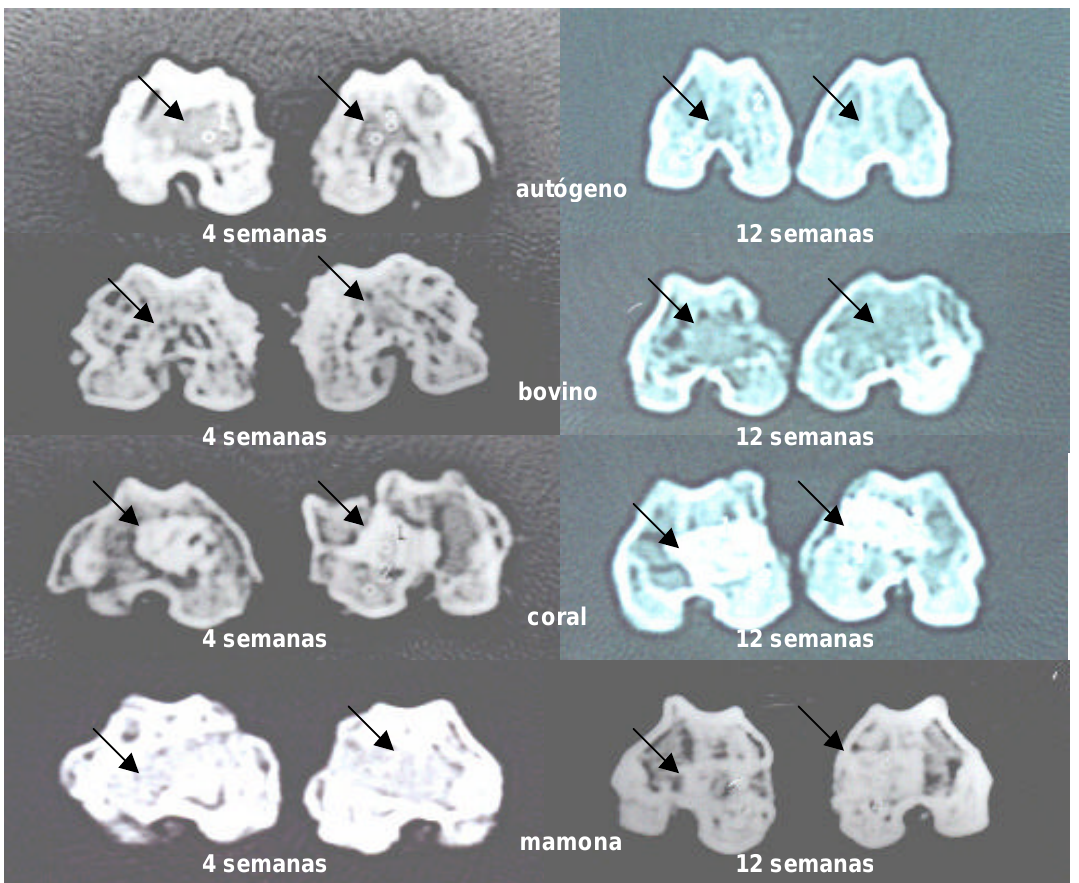
FIGURA 1 – Fotografia mostrando o aspecto da radiodensidade do osso condilar e dos implantes (setas), observados pela tomografia